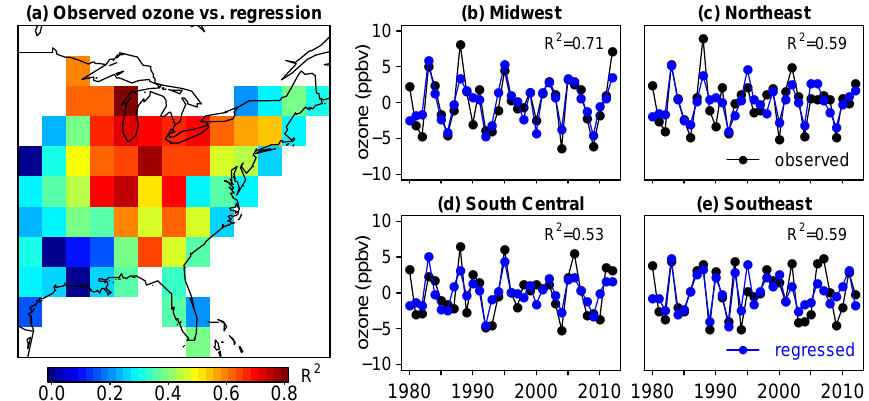
Figure 8. (a) Coefficients of determination ( R 2 ) for the linear regression of mean JJA MDA8 ozone concentration on the meteorological variables describing the polar jet frequency and the Bermuda High west edge from 1980 to 2012. Ozone concentrations have been detrended as described in text. Right-hand panels show the time series of observed (black) and regressed (blue) mean JJA MDA8 ozone concentrations averaged over the Midwest, northeast, south-central region, and southeast. Ozone values have again been detrended in these panels. The correlation coefficient r between the observed ozone and regressed meteorology is shown inset for each